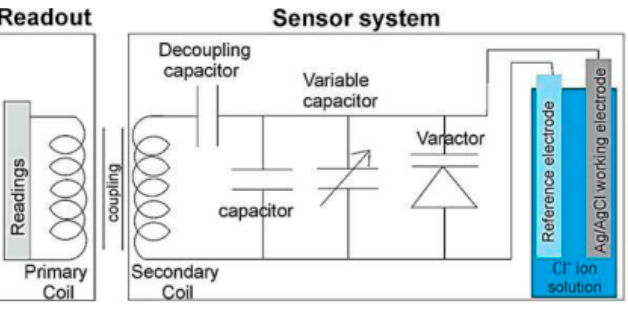
− monitoring using Ag / AgCl electrode